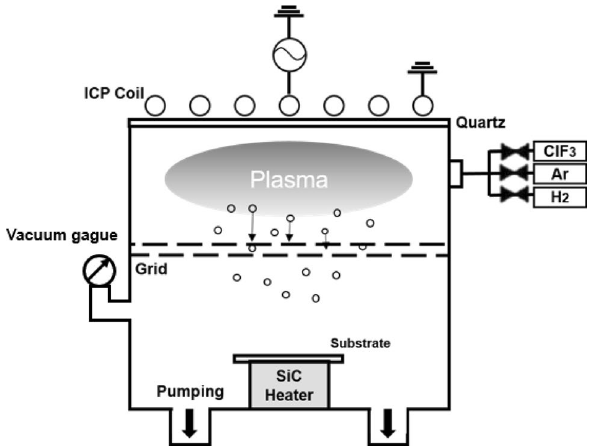
Figure 1. Schematic drawing of a remote-type inductively coupled plasma (ICP) etcher. At the center of the chamber, double grids having multiple holes are installed to prevent an ion bombardment and to deliver